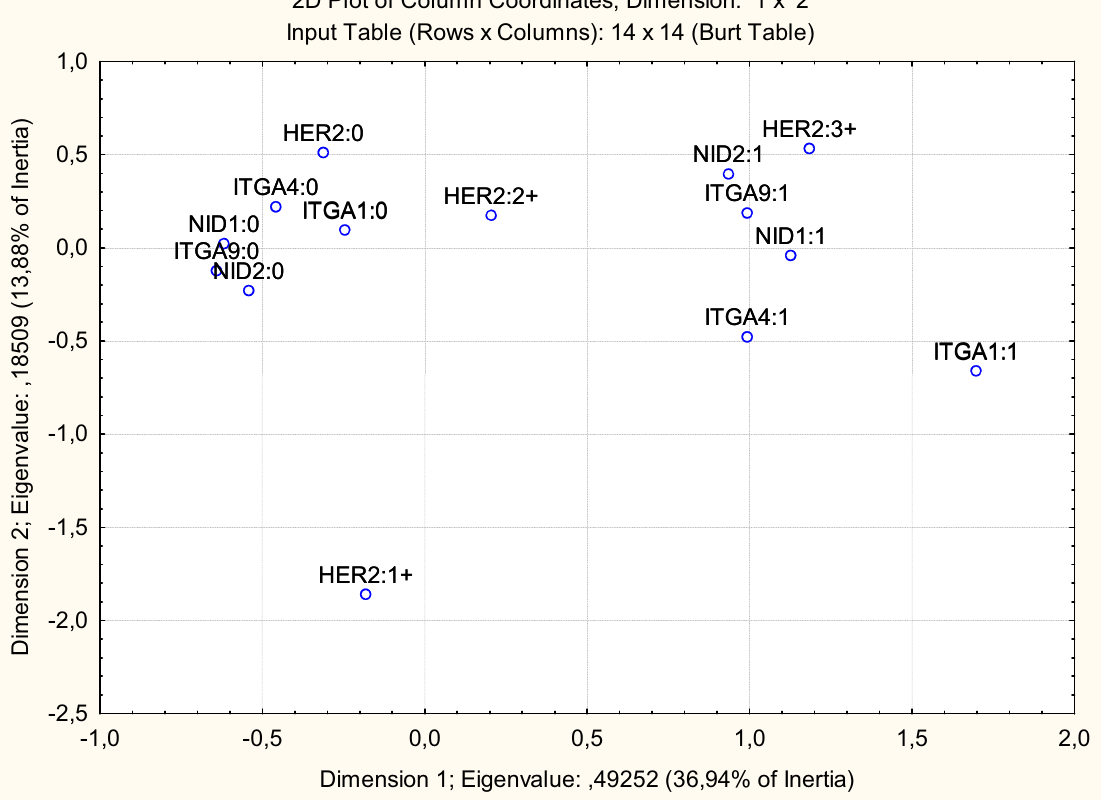
2D Plot of Column Coordinates; Dimension: 1 x 2 Input Table (Rows x Columns): 14 x 14 (Burt Table)